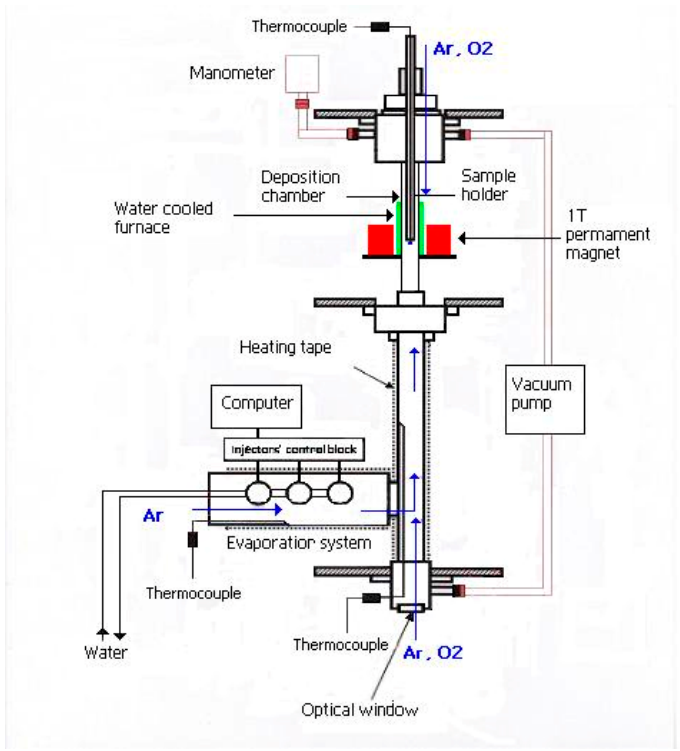
Figure 1. Schematic illustration of the PI MOCVD reactor with a 1 Tesla magnet.